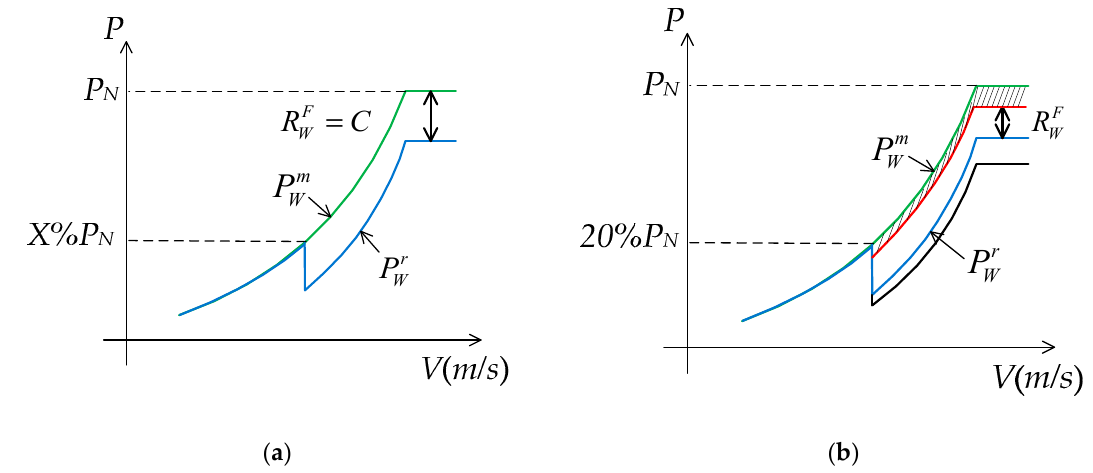
Figure 2. Primary reserve of wind power; ( a ): constant power reserve of the wind power, ( b ): primary reserve constraint of the wind